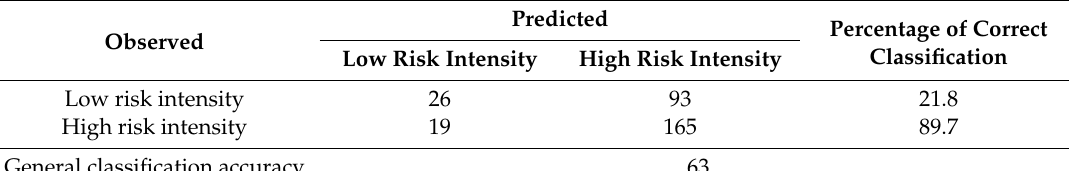
Table 4. Classification table in the logistic regression model for high risk of insu ffi cient profits.